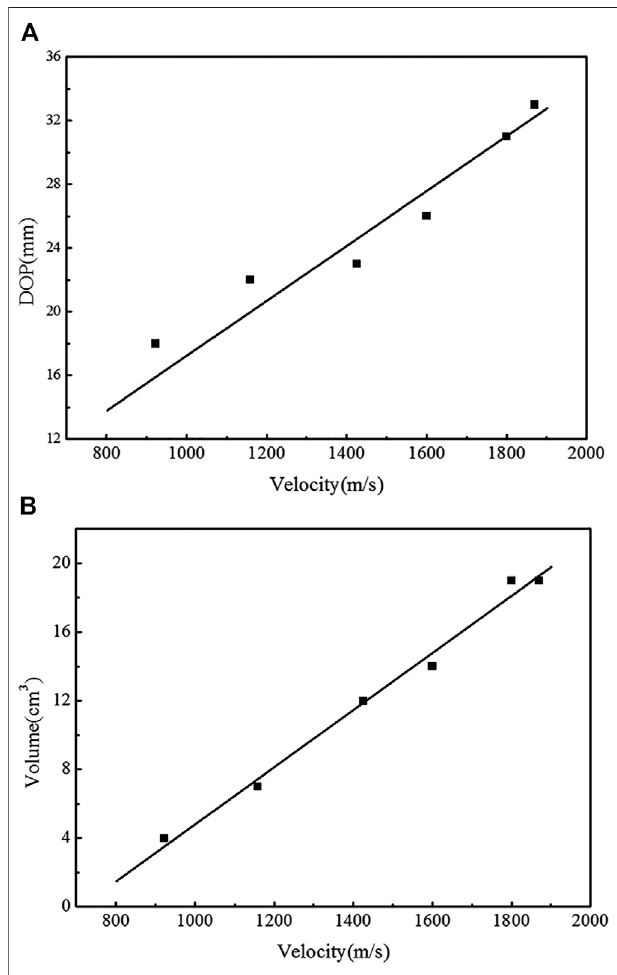
FIGURE 6 | (A) Depth of penetration, and (B) crater